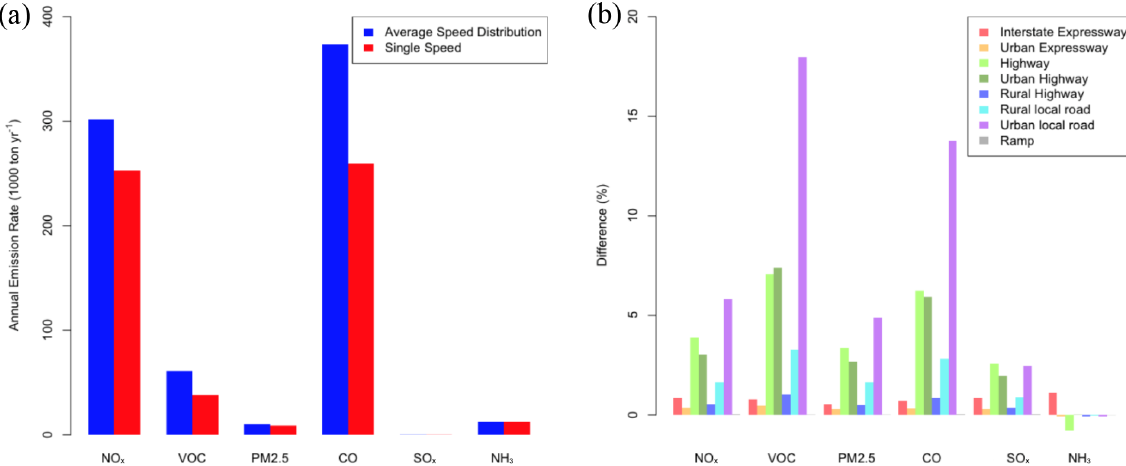
Figure 9. The impacts of emissions between the ASD and single-speed approach: (a) the total emission differences by pollutant and (b) the road-specific difference (%) by